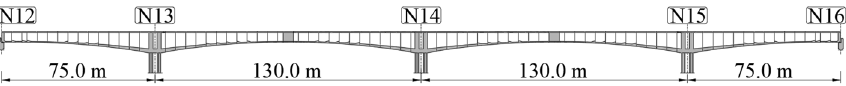
Fig. 11 Elevation of Girga Bridge over the Nile River